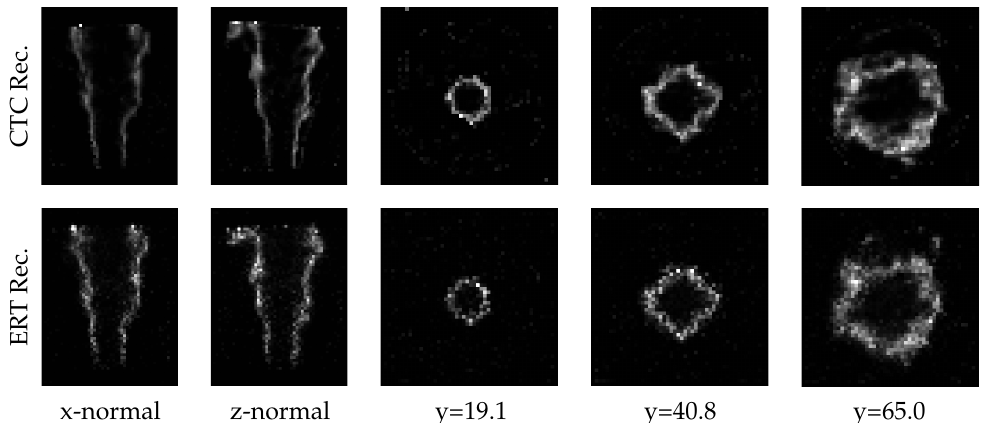
Figure 15. Vertical slices at the flame center (x-normal and z-normal), and horizontal slices at different heights above burner exit (in